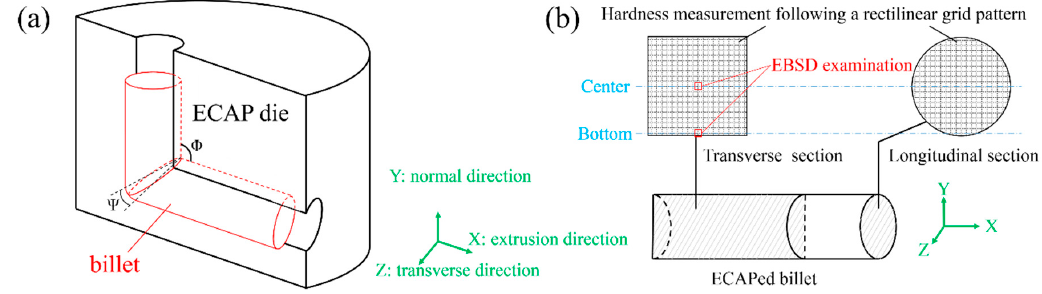
Figure 1. Schematic illustrations of ( a ) the equal channel angular pressing (ECAP) process and ( b ) the hardness measurement and electron back-scattered diffraction (EBSD) examination.